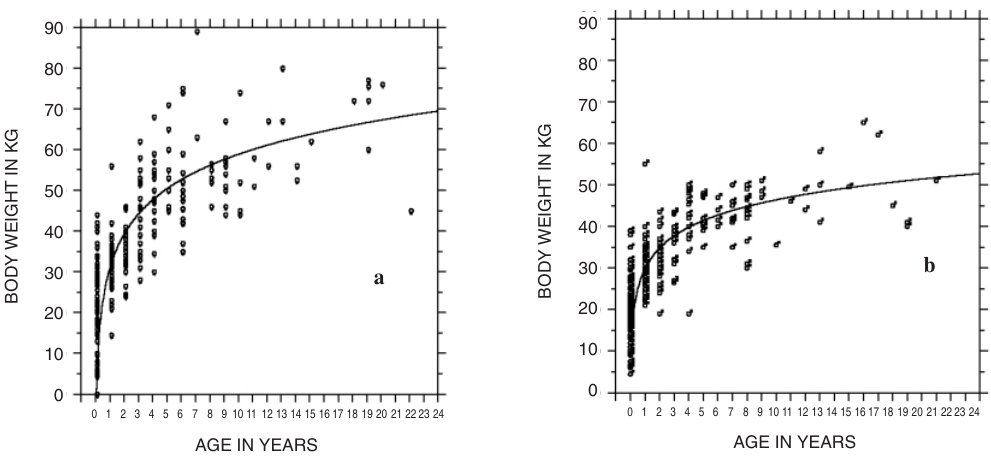
Fig. 6. Body weight at age of porpoises from strandings and bycatches. a. females; b. males.